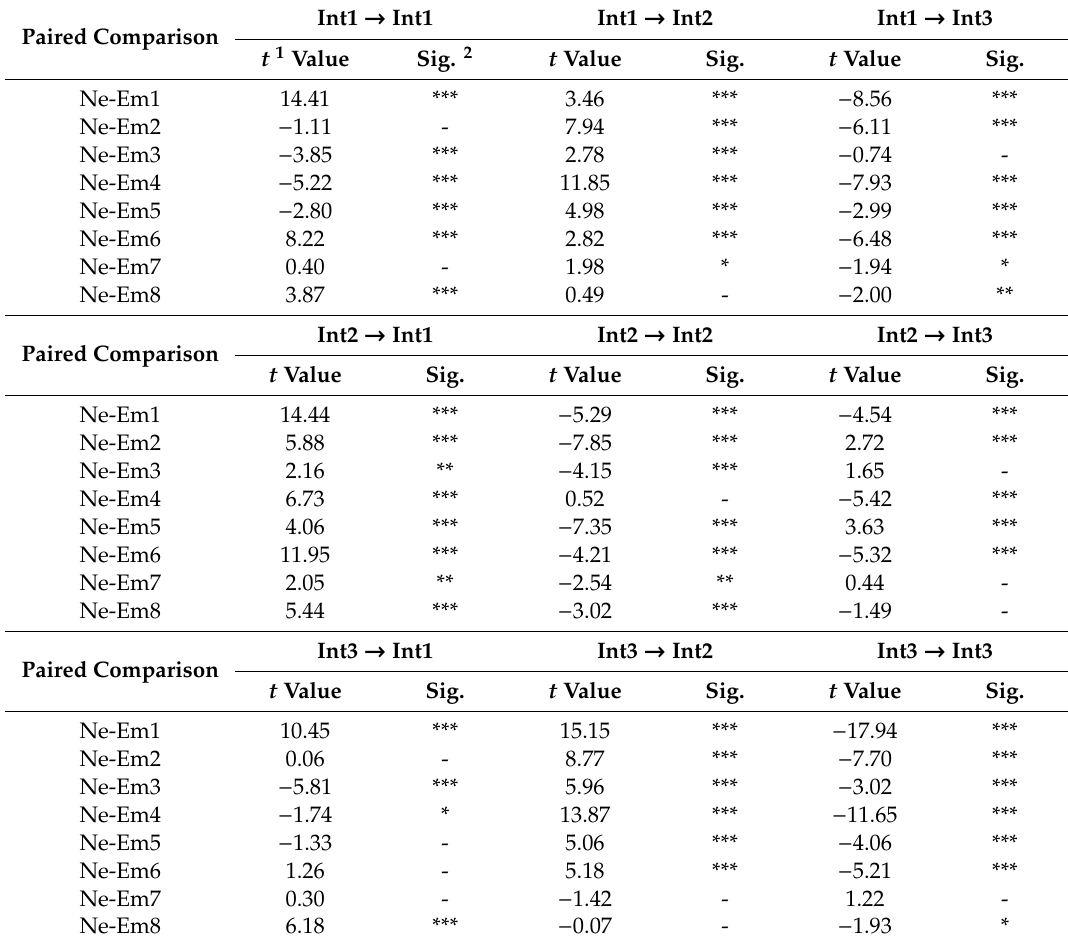
Table 10. t -test for transition probability of driving